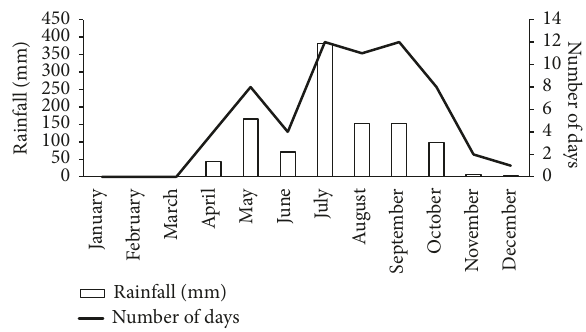
Figure 1: Number of days of rain and monthly rainfall during the experimental year